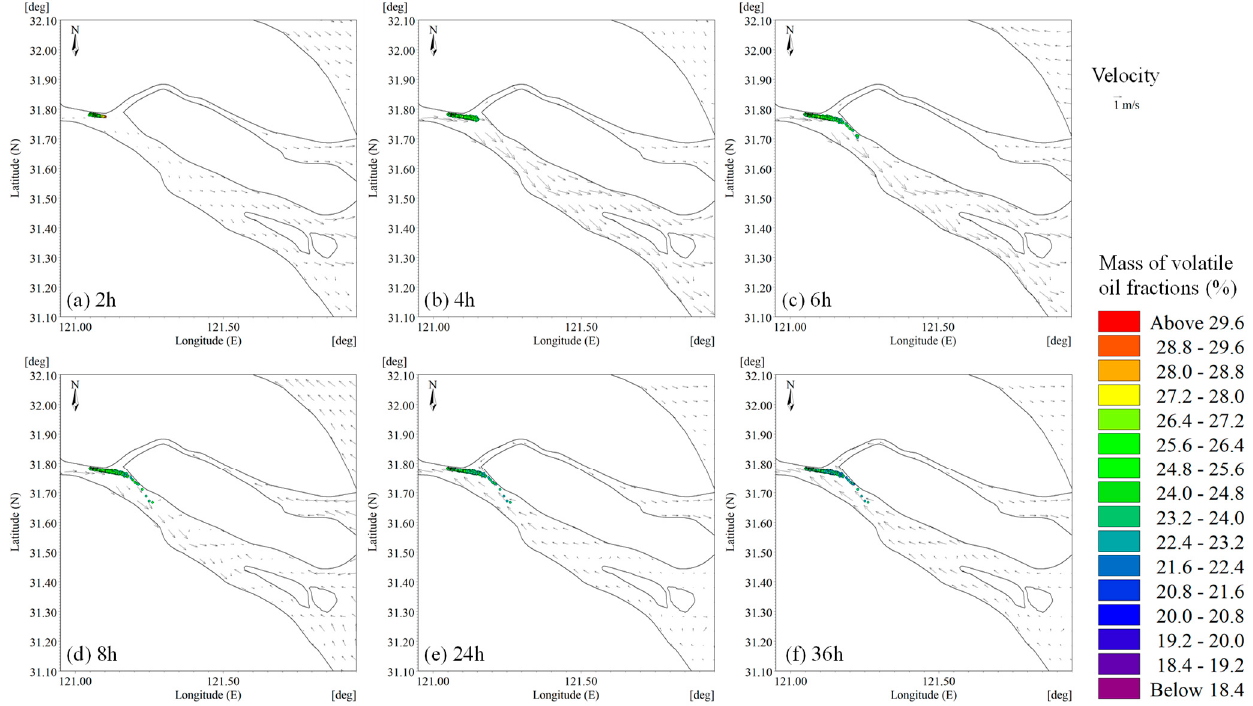
Figure 8. ( a – f ) Time evolution of oil particle tracks within 36 h starting at 1:00 on 23 September 2014 during Typhoon Fongwong affected the YRE. The color of circles means the mass of volatile oil fractions whose weight is below 160 g/mol, boiling point well below 300 deg C.